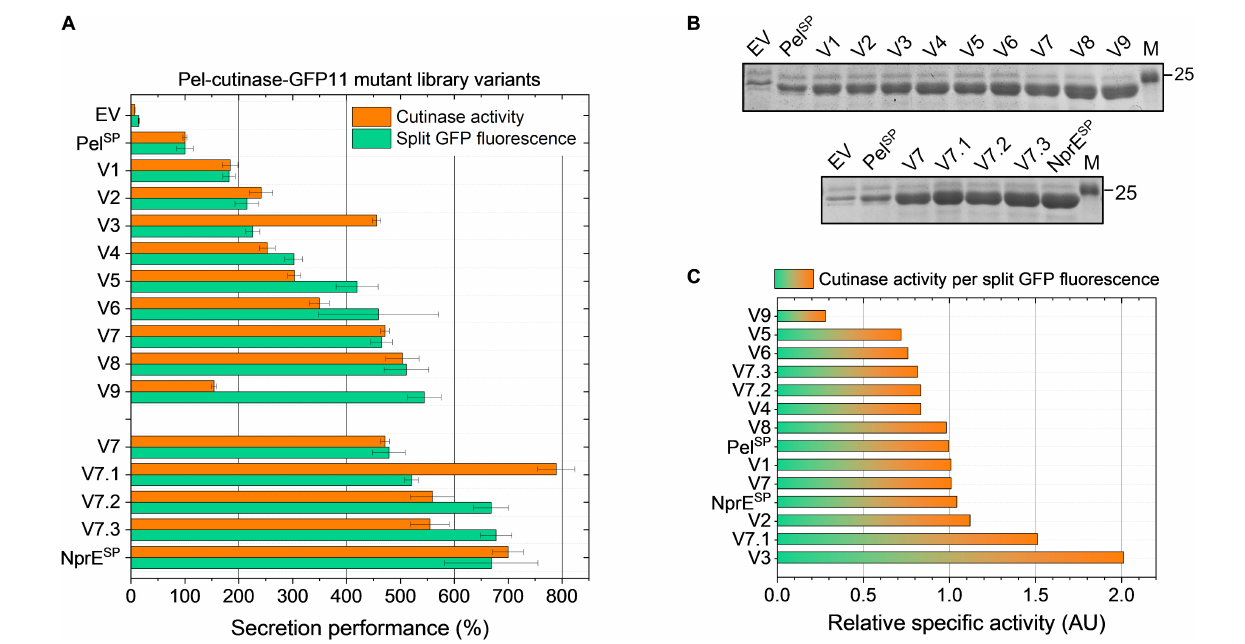
FIGURE 3 | Secretion performance of the variants isolated from the Pel SP -cutinase-GFP11 mutant libraries. Plasmids were isolated from the clones isolated after FACS-based screening of the primary mutant library Pel L1 (V1–V9) and the second-generation library Pel L2 based on V7 (V7.1–V7.3) and then re-introduced in the C. glutamicum K9 biosensor strain. The recombinant strains were grown in CGXII medium containing 1% (v/v) glucose in a BioLector for 24 h at 30 ◦ C, 1,200 rpm and 85% relative humidity along with the control strains harboring pPBEx2 (EV), pPBEx2-NprE-cutinase-GFP11 (NprE SP ) or pPBEx2-Pel-cutinase-GFP11 (Pel SP ). Four hours after inoculation, IPTG was added (250 µ M) to the cultures. At the end of the cultivation (24 h) the amount and activity of the extracellular cutinase-GFP11 was determined by (A) split GFP fluorescence and cutinase activity measurements, respectively. The secretion performance is shown relative to that of the wild-type Pel-cutinase-GFP11 (Pel SP ), which was set to 100%. (B) Complementary SDS-PAGE analysis of the extracellular levels of cutinase-GFP11 (expected size 25.1 kDa). The proteins were visualized by Coomassie Brilliant Blue staining. M, marker proteins with Mw indicated in kDa. (C) The relative specific activity for each variant was obtained by dividing the cutinase activity (%) by the split GFP fluorescence (%). The specific activity of the indicated variants relative to Pel SP is shown in ascending order.